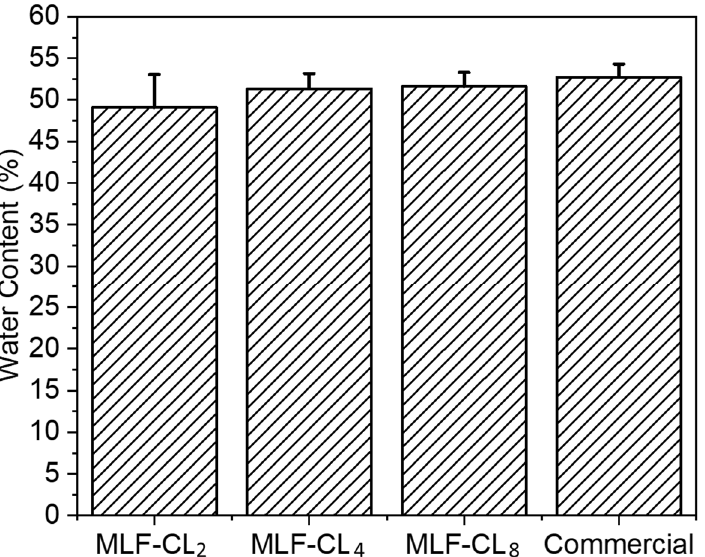
Figure 3. Equilibrium water content for miltefosine-eluting contact lenses (MLF-CLs) compared to commercial contact lenses. Quantitative data are expressed as mean ± standard deviation (SD). No significant statistical difference among samples by Kruskal–Wallis Test. p = 0.49, n = 4.